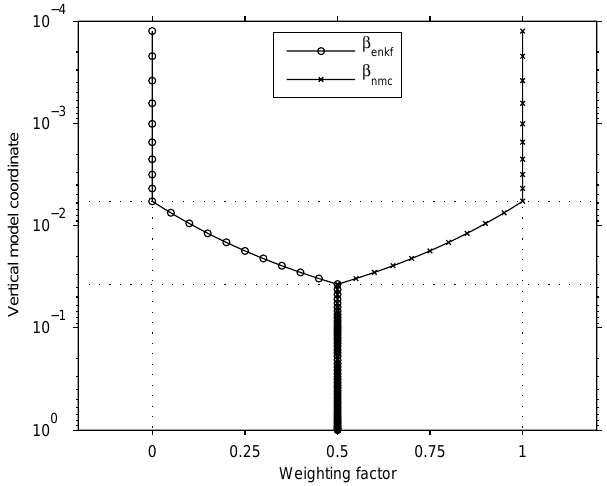
Fig. 1. The hybrid covariance weights used in computing the av- erage of the B enkf (line with circles) and B nmc (line with crosses) covariance matrices for the EnVar